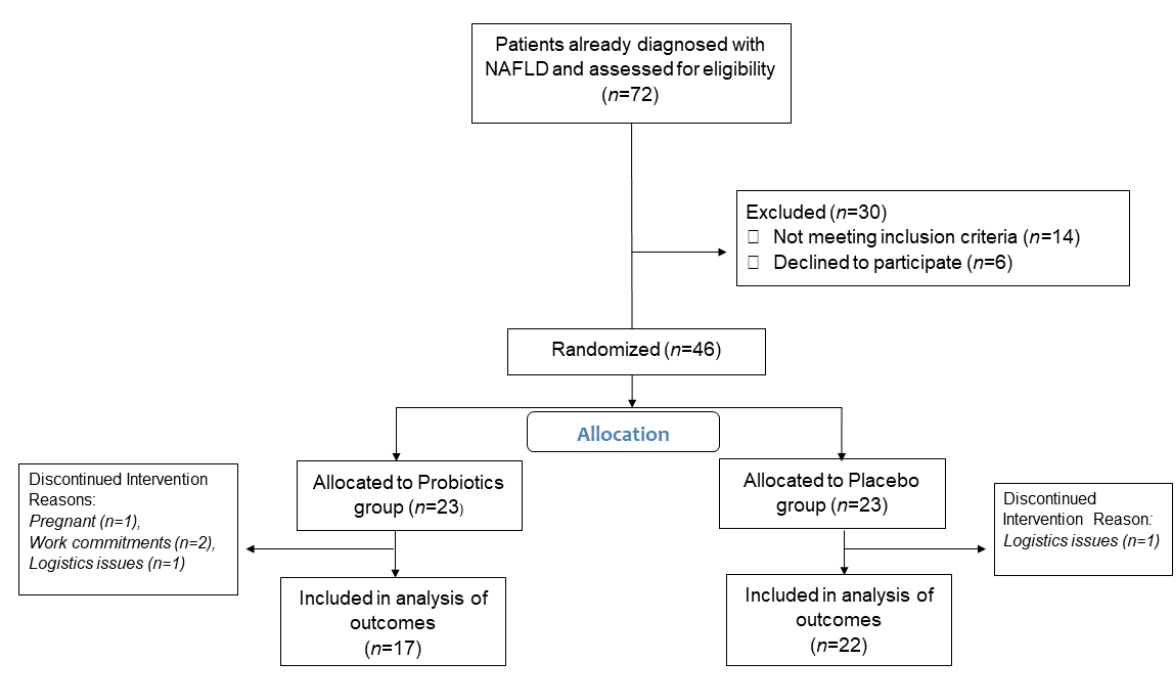
Figure 1. Consolidated Standards of Reporting Trials flow diagram of the study participants. NAFLD, non-alcoholic fatty liver disease.